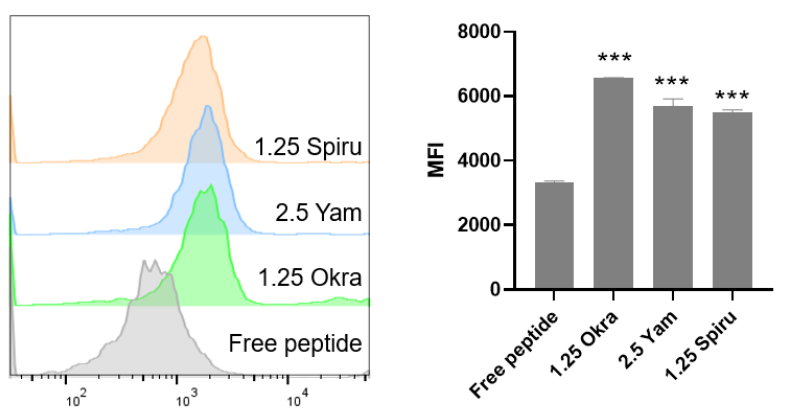
Figure 6. Peptide uptake by Caco-2 cells in vitro. A total of 100 μL of 0.05 mg/mL free FITC-modified peptide or peptide-loaded double emulsion was added and incubated for 2 h at 37 °C. Flow cytometry was employed to observe the FITC-labeled peptide uptake by Caco-2 cells. *** p < 0.001, ns, no significance.